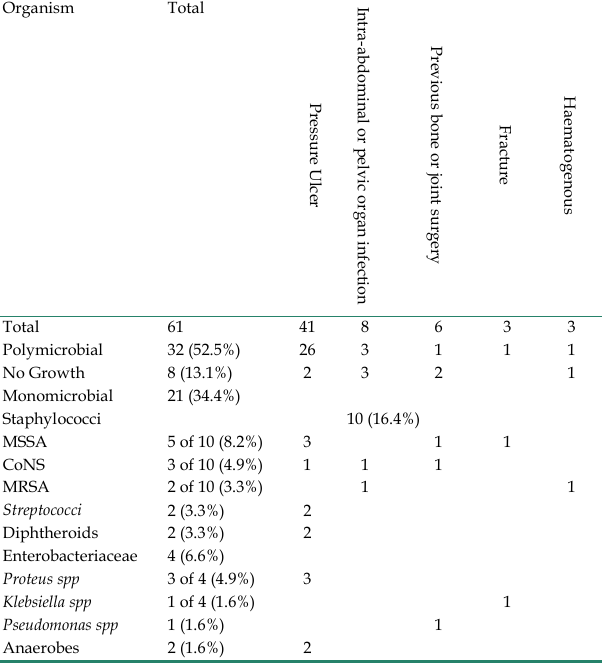
Table 3. Breakdown of organisms cultured Organism